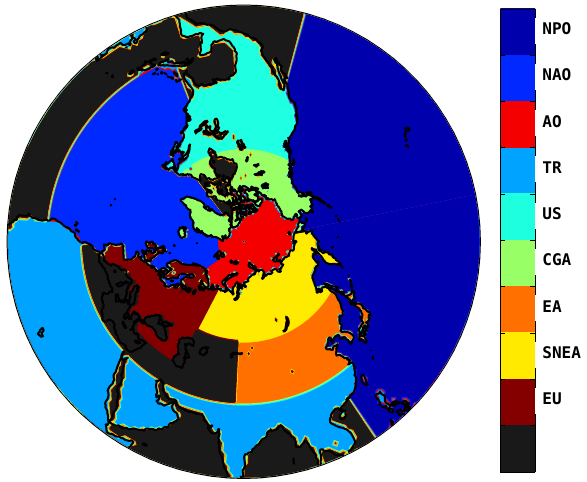
Fig. 1. Geographical regions used for the clustering of the footprint emission sensitivities. NPO, NAO and AO represent the North Pa- cific Ocean, North Atlantic Ocean and Arctic Ocean respectively. TR represents the land masses in the tropics and southern hemi- sphere. US is USA (except Alaska and Hawaii) and Central Amer- ica. CGA stands for Canada, Greenland and Alaska. EA, SNEA and EU represent Eastern Asia, Siberia and North-East Asia and Europe